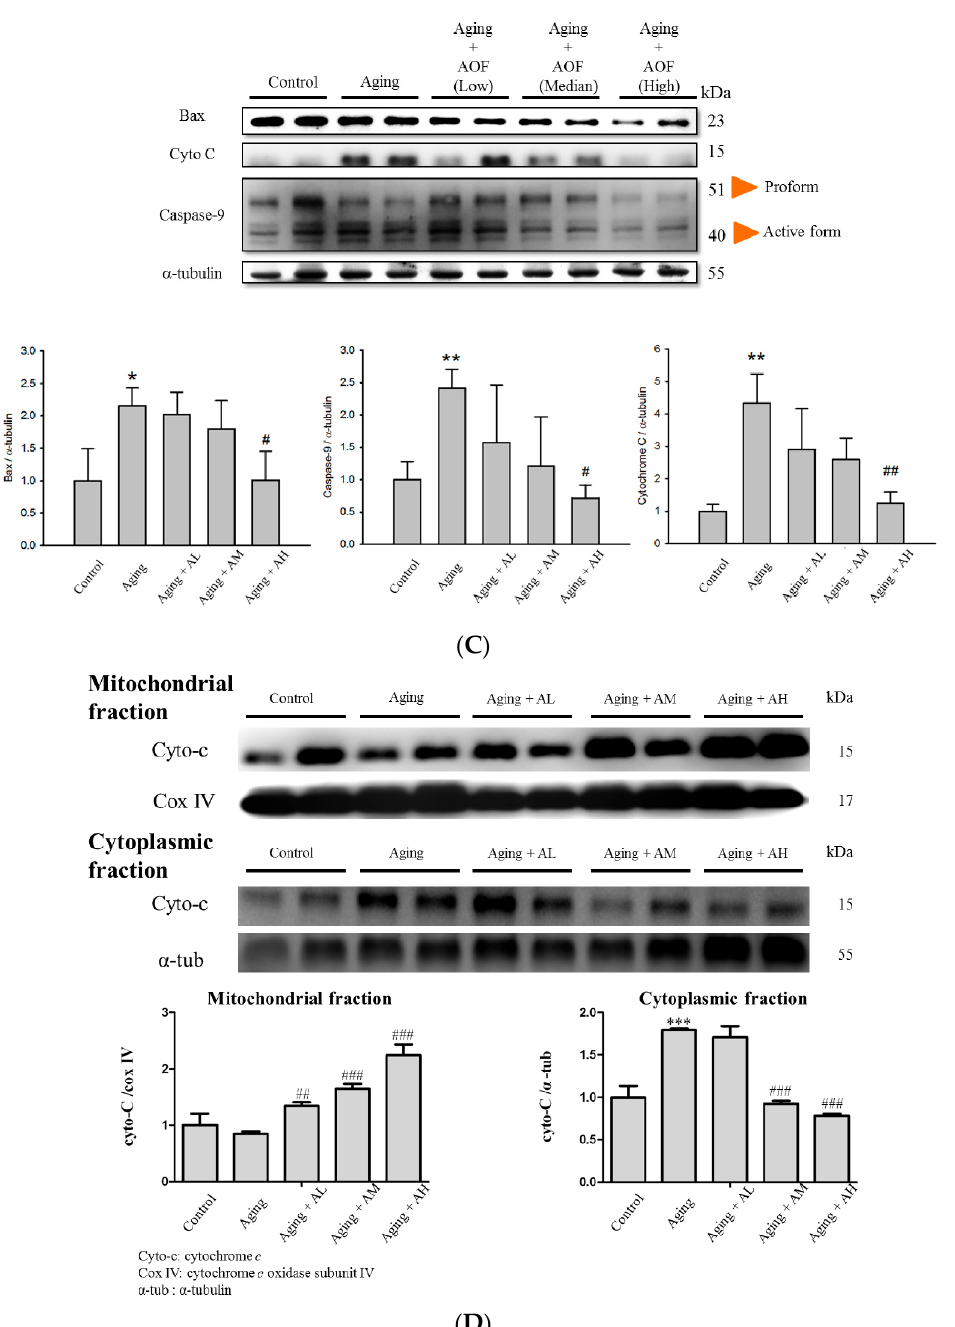
Figure 4. Effect of AOF on D -galactose -induced apoptosis in SD rat cardiac tissue. ( A ) Immunohistochemical analysis for cleaved Caspase-3 in sections from the SD rat cardiovascular tissue. The protein levels decreased with AOF treatment and are shown in a brown color. Final magnifications: ×400 (bar, 50 μ m). The total protein of SD rat cardiac tissue extracts was separated by 12% SDS polyacrylamide gel electrophoresis (SDS-PAGE), transferred to polyvinylidene difluoride (PVDF) membranes, and immunoblotted with antibodies against Fas, Fas-associated death domain (FADD), caspase-8, cleaved caspase-3, B-cell lymphoma 2-associated X protein (Bax), cytochrome c and caspase-9 antibody to detect apoptotic markers expression ( B , C ); Levels of cytochrome c were determined from cytoplasmic and from the mitochondria ( D ). Equal loading was assessed with an anti- α -tubulin antibody. These blots were quantified by densitometry. α -tubulin served as a loading control. Data are presented as means ± S.D. Bars indicate averages, * p < 0.05; ** p < 0.01; *** p < 0.001, represent a significant difference versus the control; # p < 0.05; ## p < 0.01; ### p < 0.001, represent a significant difference versus the aging group. n = three independent experiments for each data point.